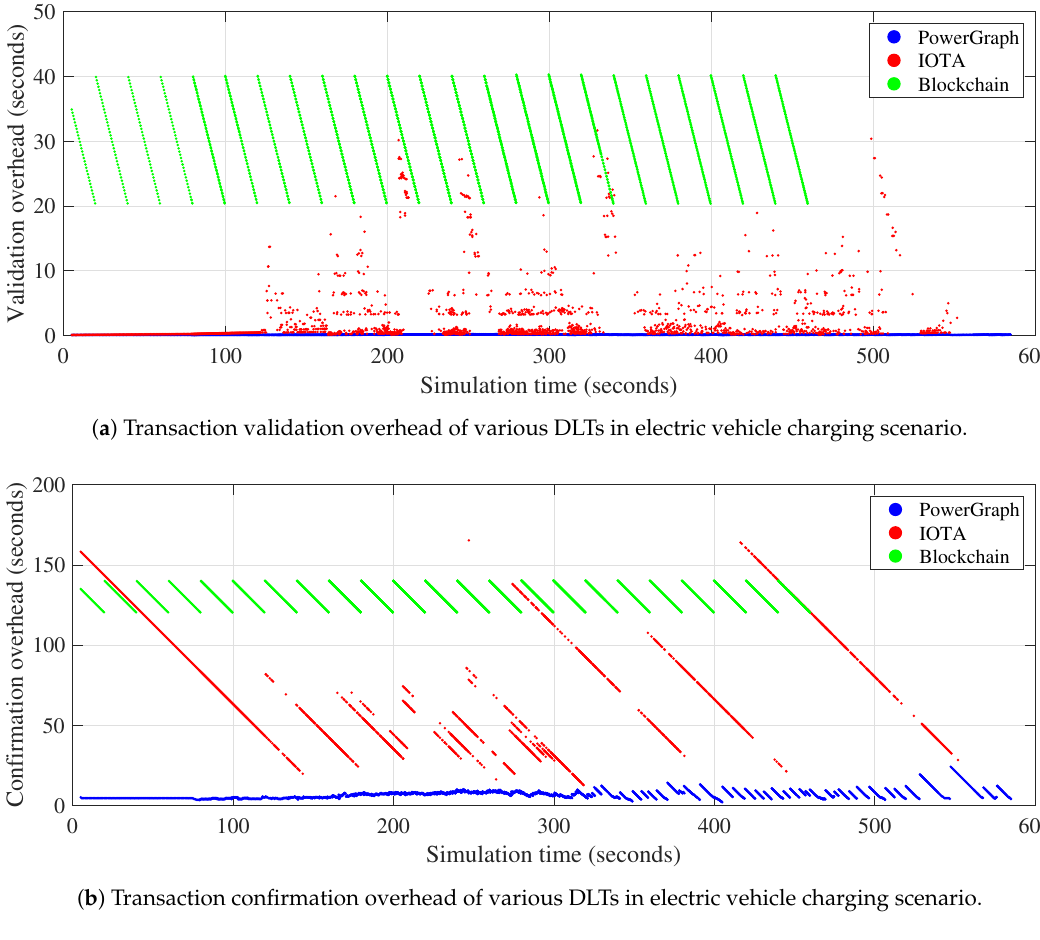
Figure 13. Simulation results in electric vehicle charging scenario.